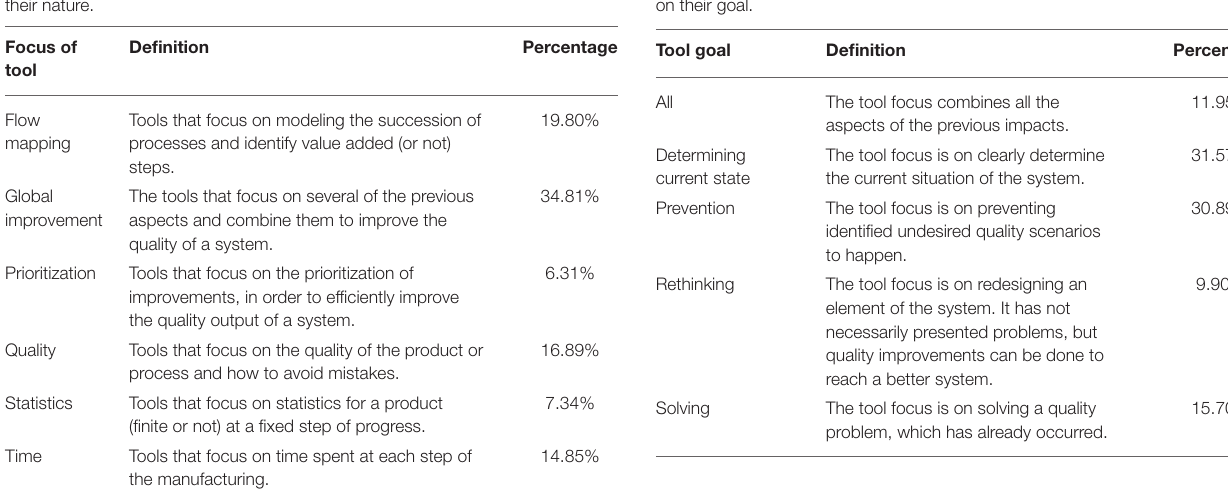
TABLE 6 | Definition of the different options of the first classification of tools on their nature.